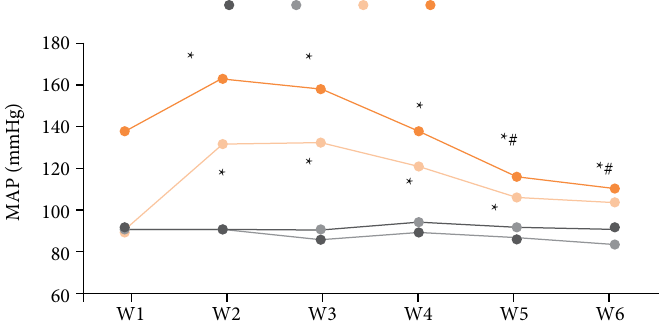
Figure 6 - Noninvasive blood pressure of rats (1–4 are conditions 5 min after ether anesthesia, 5 min after administration intervention, 10 min after modeling, and after AWR stimulation, respectively).